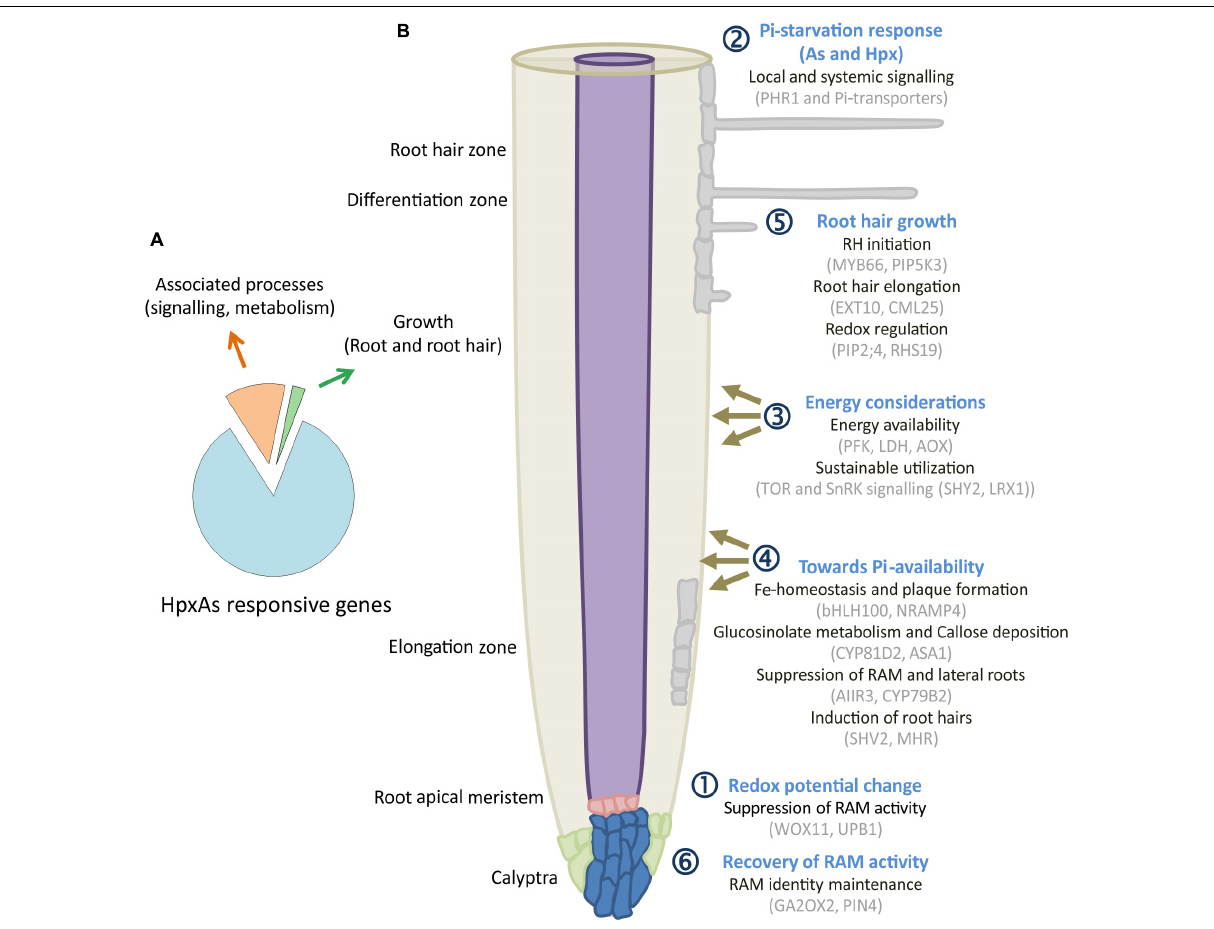
Frontiers in Plant Science |